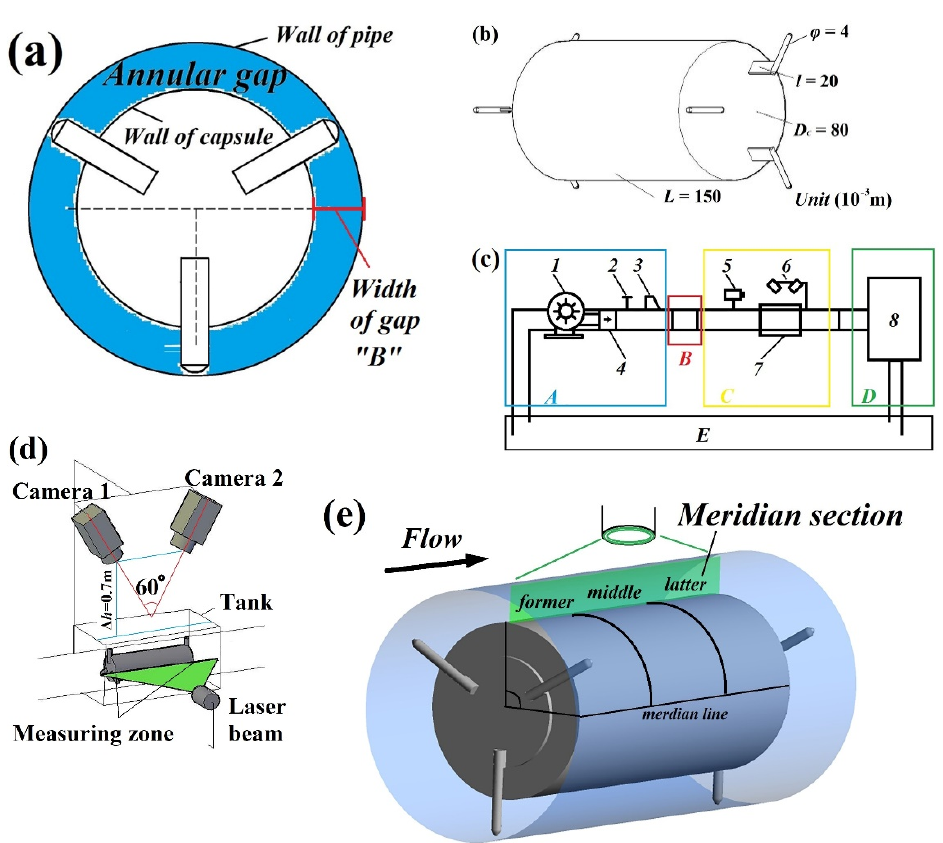
Figure 1. Schematics of the experimental model and annular gap flow: ( a , b ) schematics of annular gap and size parameters of the capsule; ( c ) components of the experimental system; ( d , e ) setup of the PIV system and schematic of the meridian section.